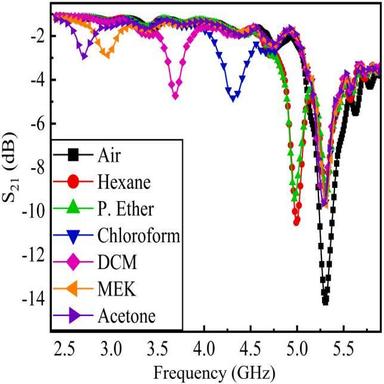
Experimentally measured results for organic LUTs with the fabricated sensor.